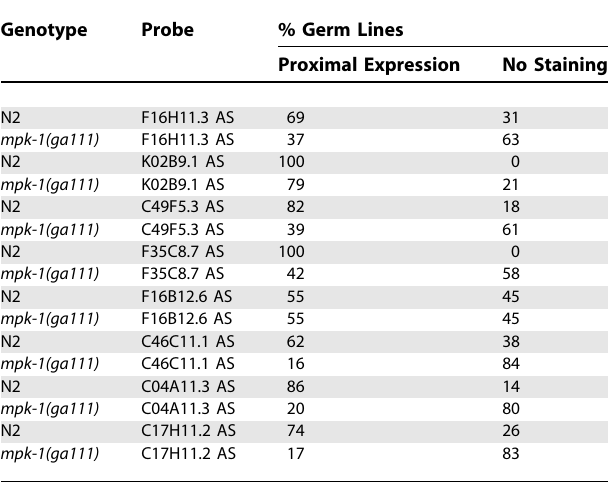
Table 4. In Situ Hybridization Analysis of X-Linked MPK-1